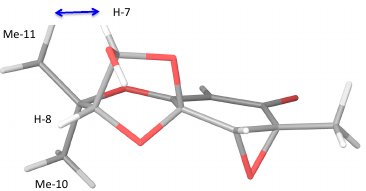
Figure 1. Three-dimensional image of stereoisomer 4d showing nOe to Me-11.